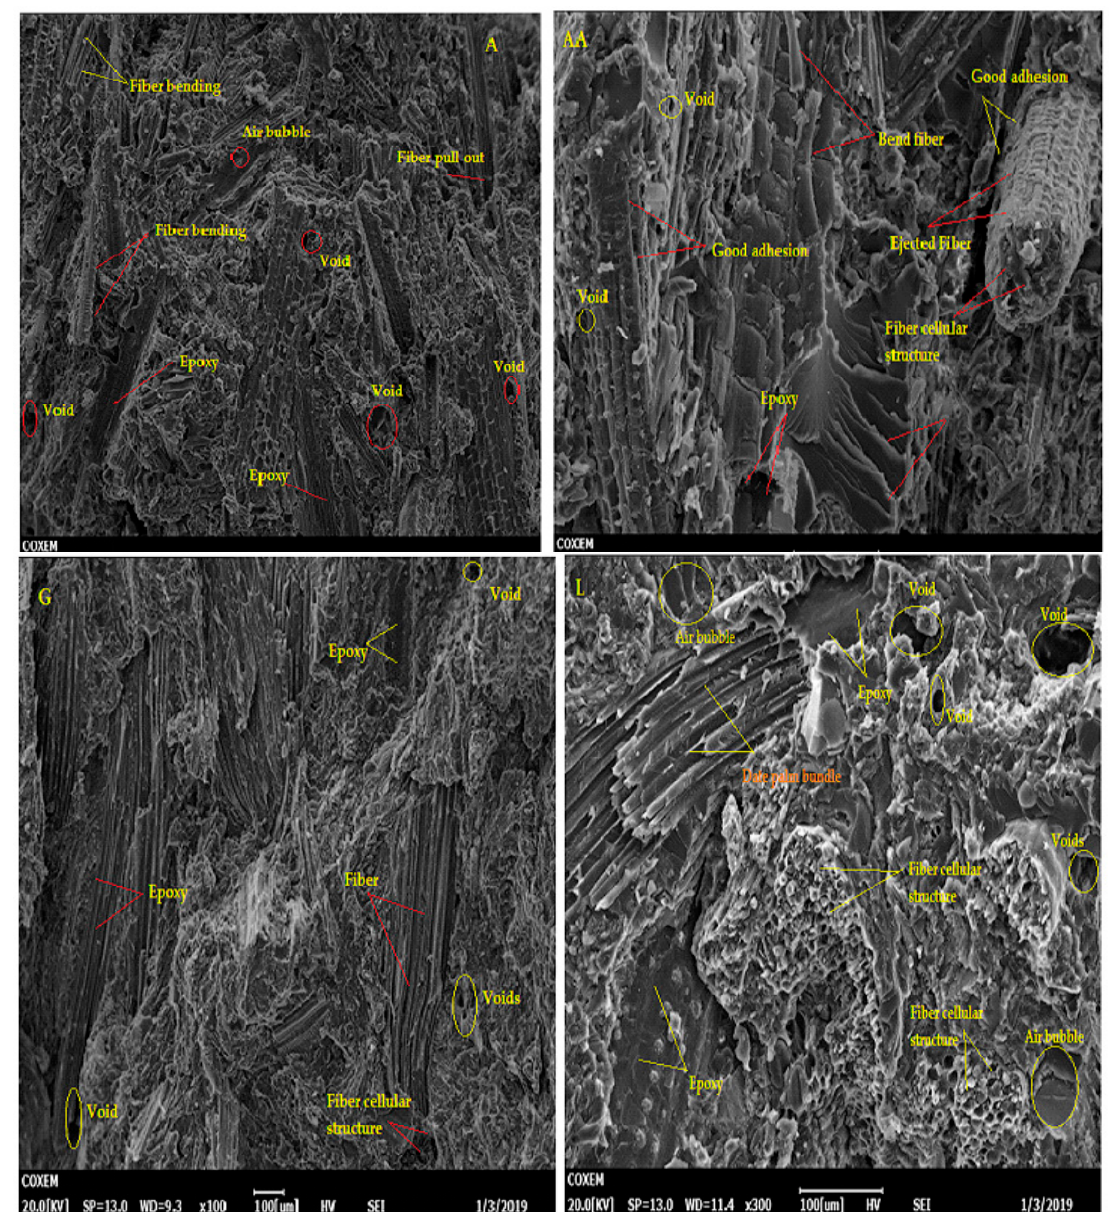
Figure 11. SEM images of DPF/epoxy composites.